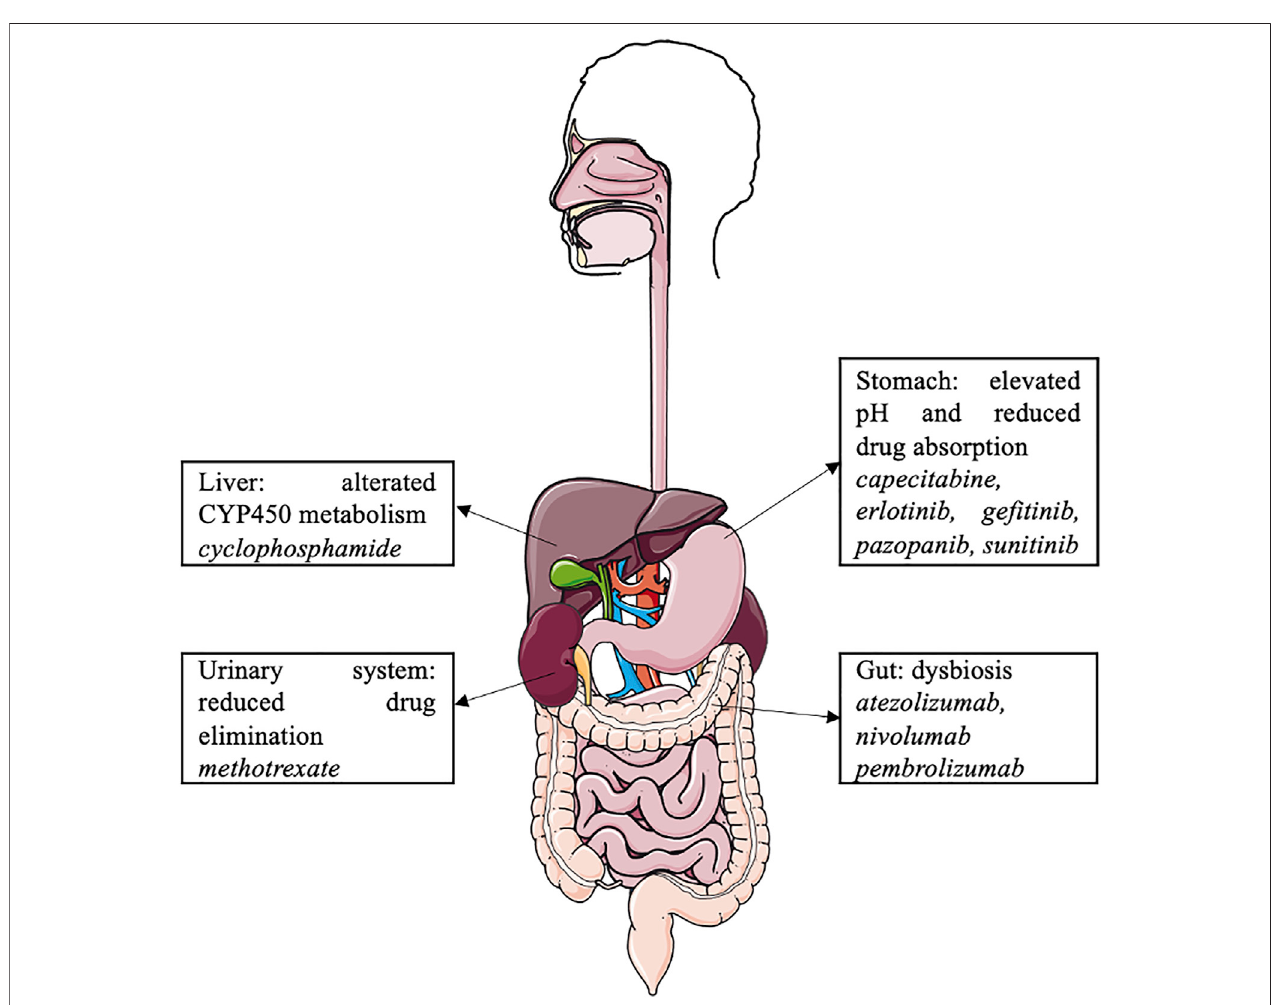
FIGURE 2 | PPI-induced interactions between organ functions and anticancer